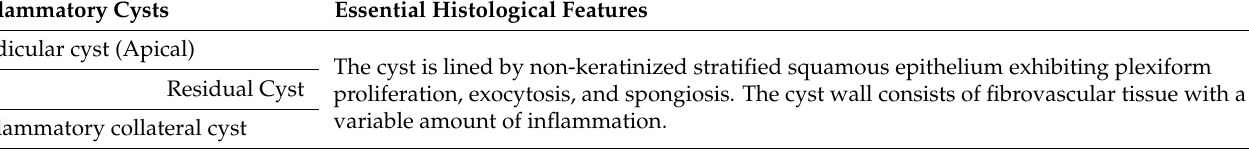
Table 2. Histological feature of odontogenic cyst based the 5th edition of WHO [2]. Inflammatory Cysts Essential Histological